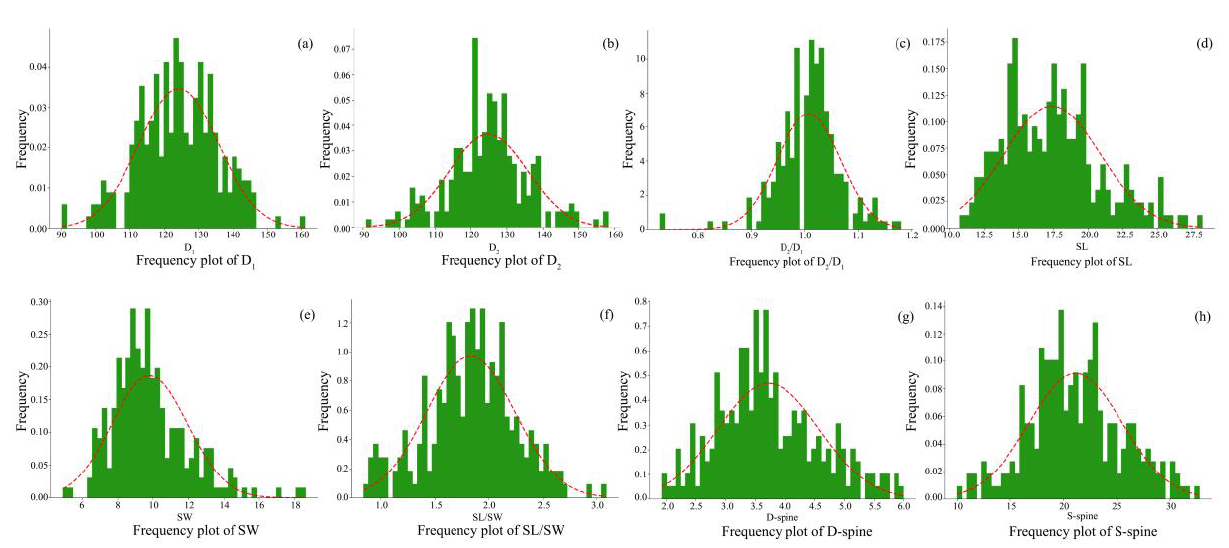
Figure 3. Histograms of eight quantitative traits of Hibiscus syriacus based on 240 measured pollen grains. Shown is the normalized frequency of D 1 , D 2 , D 2 /D 1 , SL, SW, SL/SW, D-spine, and S-spine for each sample of each H. syriacus cultivar. ( a ) The D 1 ranged from 90.19 to 160.95 µ m, peaking at 120~130 µ m. ( b ) The D 2 ranged from 90.90 to 158.22 µ m, peaking at 120~130 µ m. ( c ) The D 2 /D 1 ranged from 0.73 to 1.18, peaking at 1.0~1.05. ( d ) The SL ranged from 10.73 to 28.24 µ m, peaking